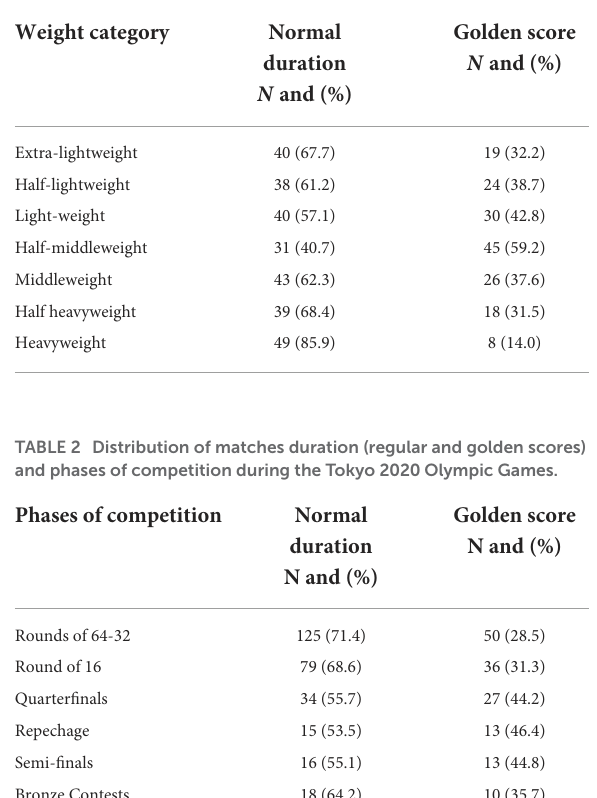
TABLE 1 Distribution of matches durations (regular and golden scores) and weight categories during the Tokyo 2020 Olympic Games.